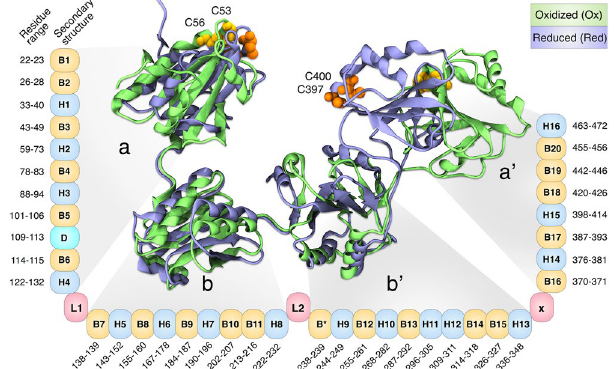
Figure 1. Structural representation of hPDI in oxidized and reduced states superimposed from bb’ domain along with secondary structure element of all residues. B: Sheet, H: Helix, D: Disordered region, L: Linker, X: X-linker. B * : Exclusive sheet in oxidized